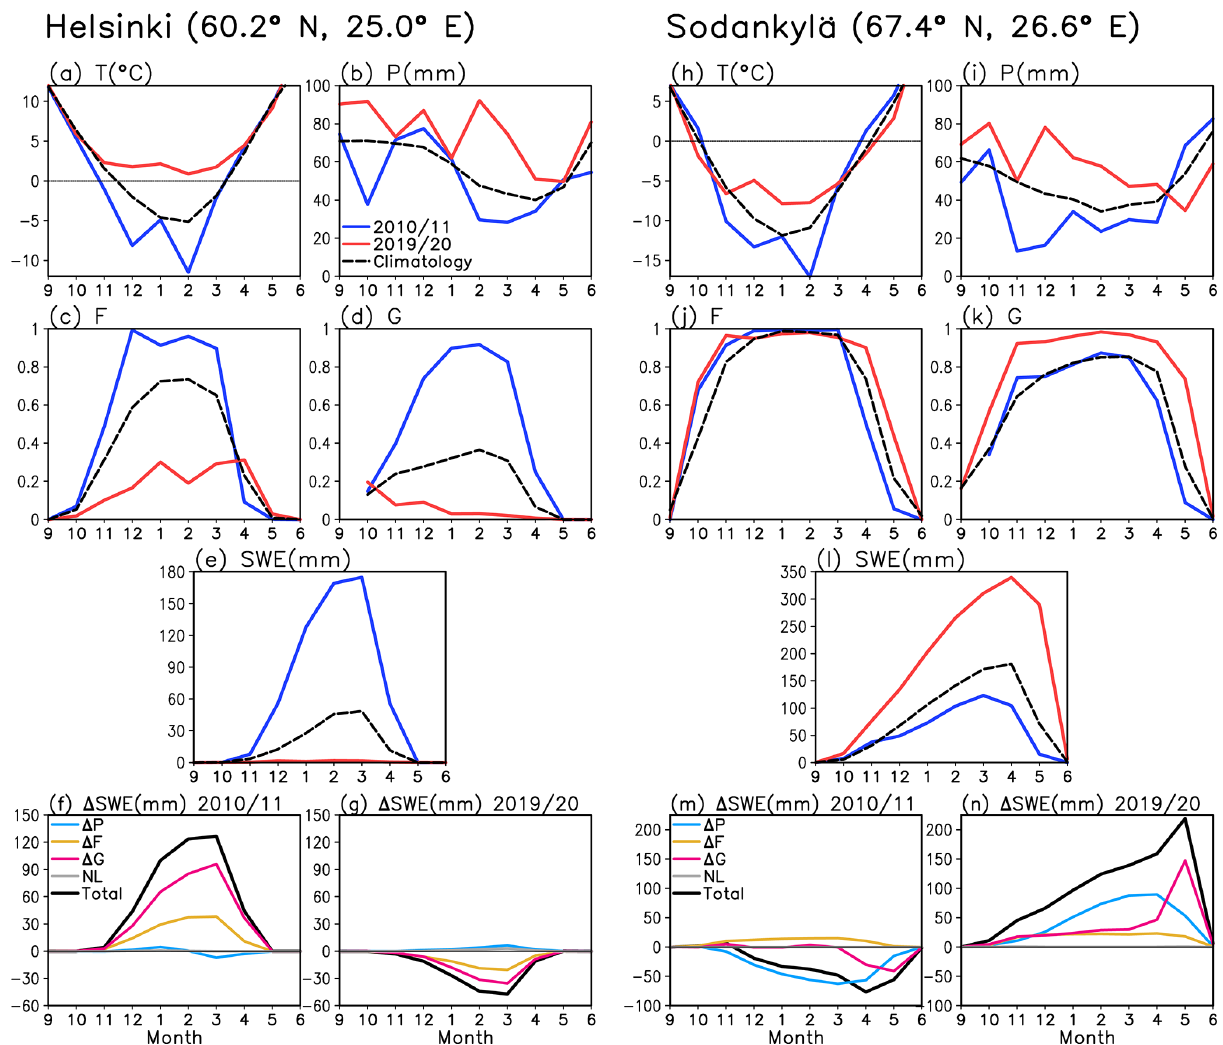
Figure 4. (a–g) Weather and SWE diagnostics for winters 2010/11 and 2019/20 for the ERA5-Land grid box closest to Helsinki. (a– e) temperature T , precipitation P , the snowfall fraction F , the snow-on-ground fraction G and SWE in 2010/11 (blue), 2019/20 (red) and the corresponding 39-winter mean values (black). (f–g) Decomposition of the winter 2010/11 and 2019/20 SWE anomalies to contributions from the four rhs terms in Eq. (2) (see the legend in f for line colours). (h–n) The same for